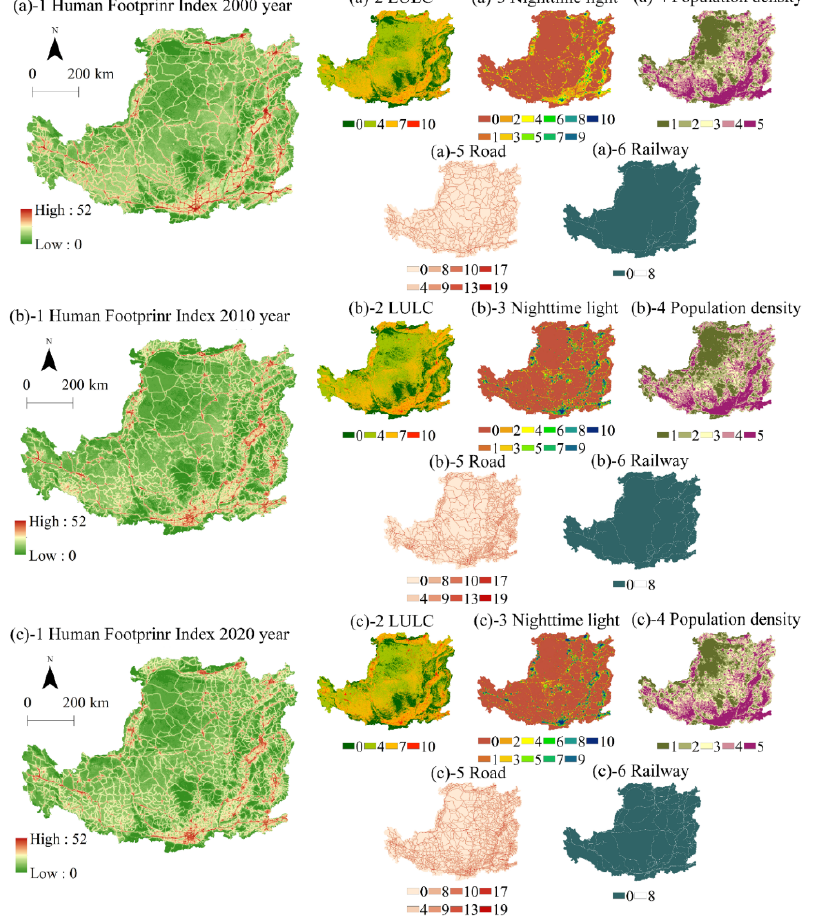
Figure 7. ( a )-1, ( b )-1, ( c )-1 is the Integrated Human Footprint Index in 2000, 2010, and 2020, respec- tively. ( a )-2 to ( a )-6 is each human footprint factor that compose the Integrated Human Footprint Index in 2000. ( b )-2 to ( b )-6 is each human footprint factor that composes the Integrated Human Footprint Index in 2010. ( c )-2 to ( c )-6 is each human footprint factor that composes the Integrated Human Footprint Index in 2020.